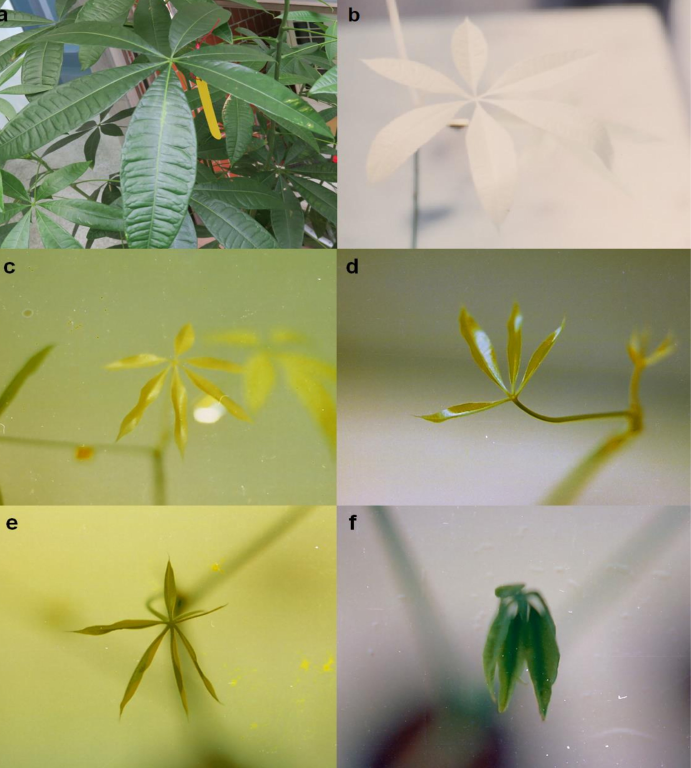
Figure 1. Two- and 3-week-old newly developed leaves of dark-grown Pachira macrocarpa plants fed various concentrations of glucose. The pictures were taken within 15 s after exposure to natural light. Mature leaves of test plants cultured in a light condition ( a ), and in a dark condition ( b ) without glucose treatments. Newly developed leaves of dark-grown P. macrocarpa plants cultured in dark conditions and fed 0% ( c ), 2% ( d ), 4% ( e ), and 6% ( f )